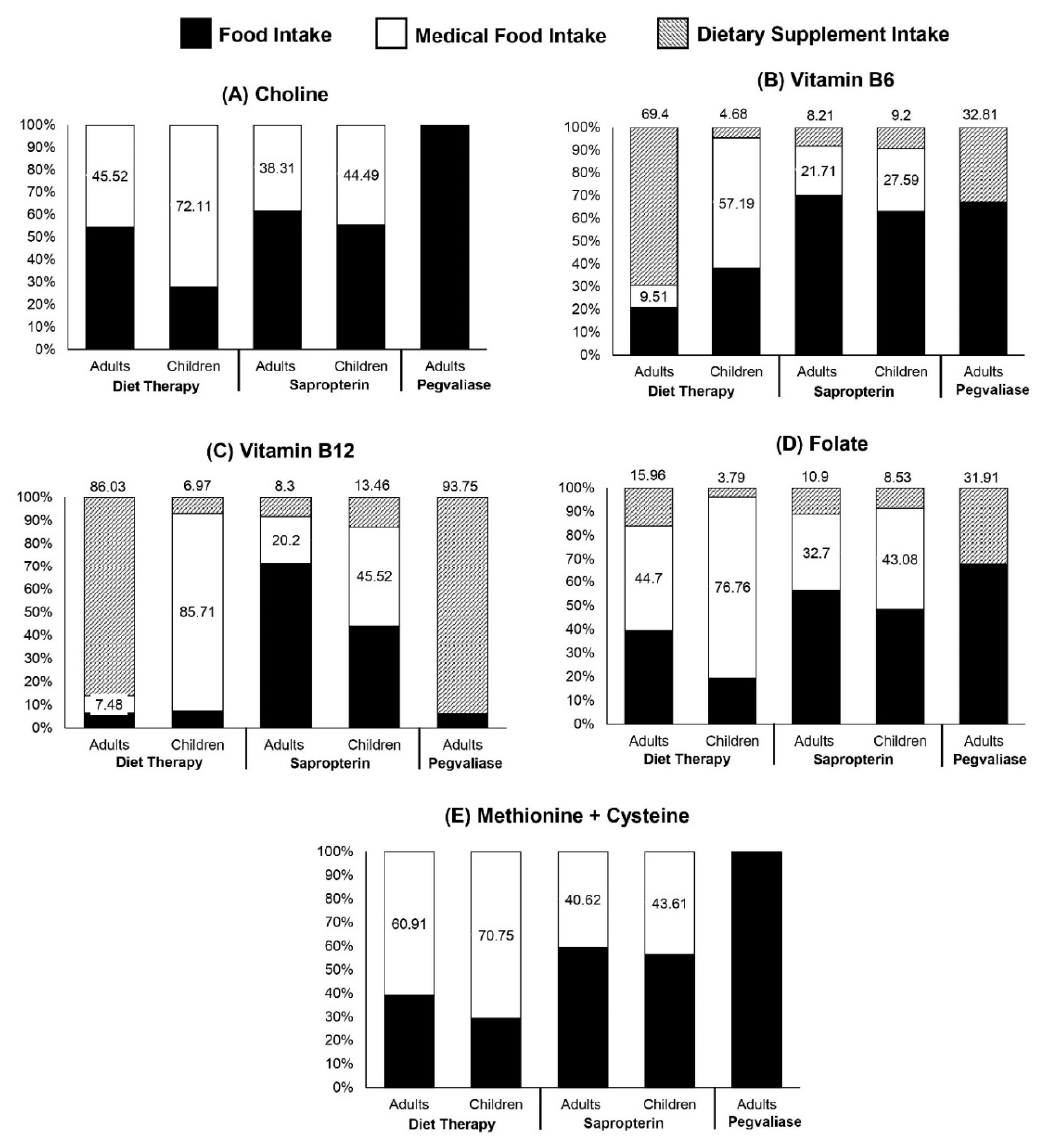
Figure 2. The contribution of food sources, medical food, and dietary supplements to total usual intakes for ( A ) choline, ( B ) vitamin B6, ( C ) vitamin B12, ( D ) folate, and ( E ) methionine plus cysteine among adults ( n = 71) and children ( n = 49) with PKU, stratified by treatment group (diet therapy, sapropterin, and pegvaliase). Percentage values within white bars represent the contribution from medical food and percentage values above each bar represent the contribution of dietary